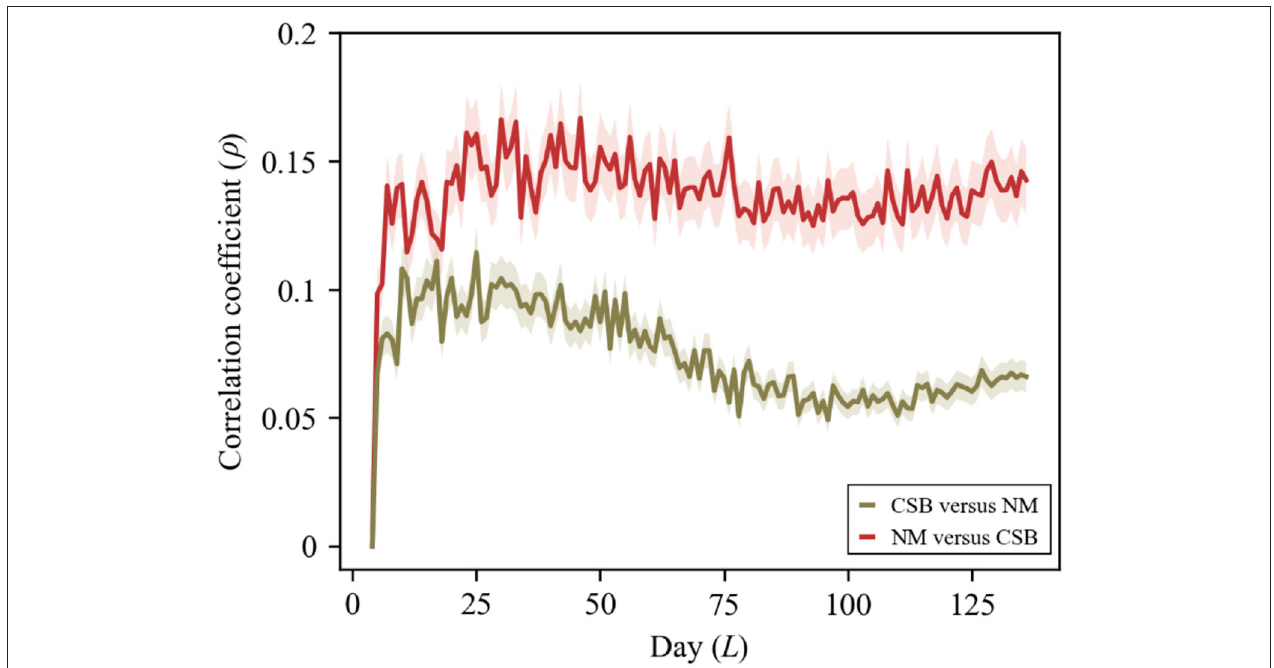
FIGURE 3 | Detecting causation with convergent cross mapping (CCM) model. With convergence, the skill of cross-map estimates, indicated by the correlation coefficient ( ρ ), increases with the cumulative interactions of the following days between 16 July and 30 November 2021 (time series length L = 138). The patterns indicate that NM vs. CSB is more powerful than CSB vs. NM. For original experimental data, please see Supplementary Table 1 of the Supplementary